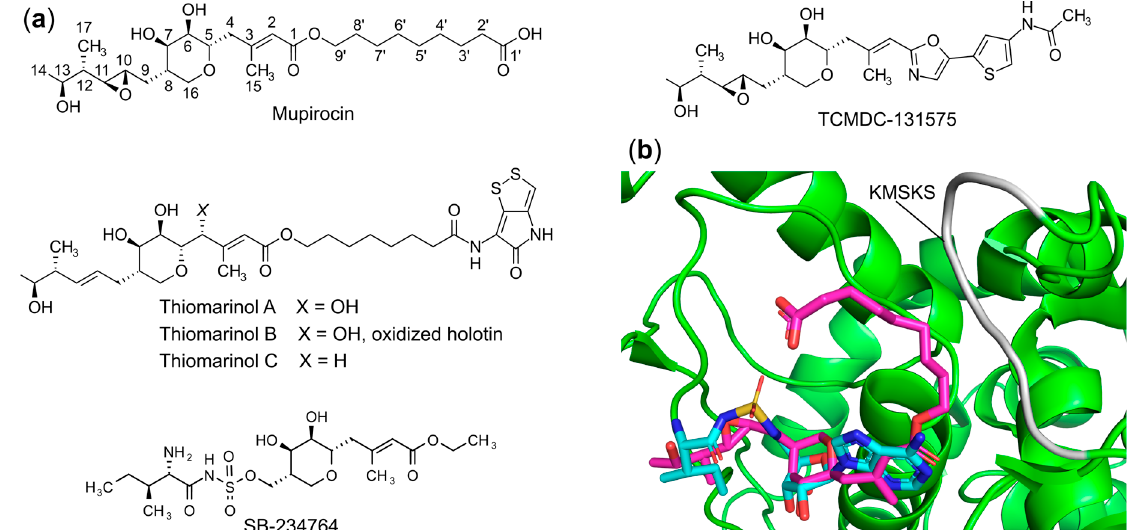
Figure 8. IleRS bi-substrate inhibitors. ( a ) Chemical structures of inhibitors targeting IleRS. ( b ) Comparison of the binding modes of mupirocin (magenta C-atoms, PDB entry: 1JZS) with isoleucyl-sulfamoyl adenosine (ISA, cyan C-atoms) in T. thermophilus IleRS. The backbone structure of IleRS is shown as a green cartoon representation with the KMSKS loop colored in grey.